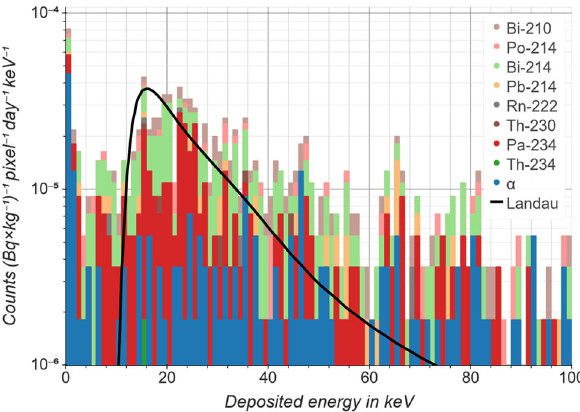
Fig. 9 Simulated spectrum of deposited energies in the MMC absorbers caused by the bulk-distributed 238 U-chain in the aluminum shielding. No special structures are observable. Mainly, electrons ( β